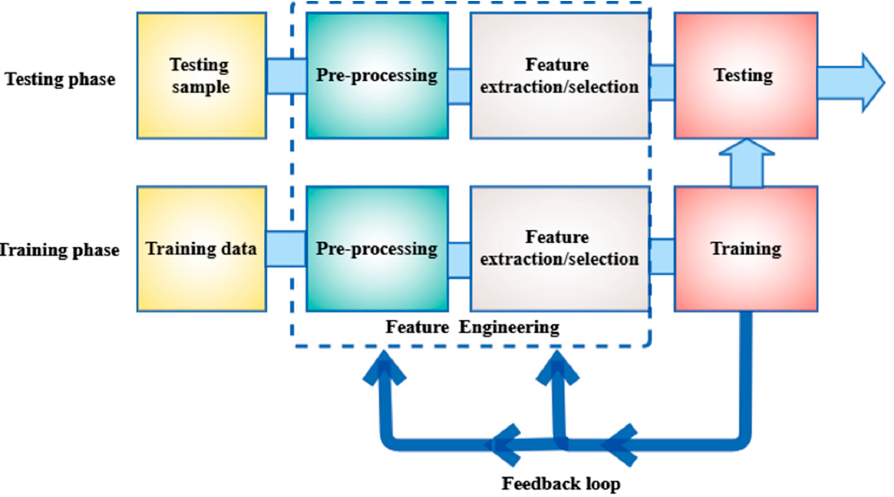
Figure 7. A typical system of machine learning [61].